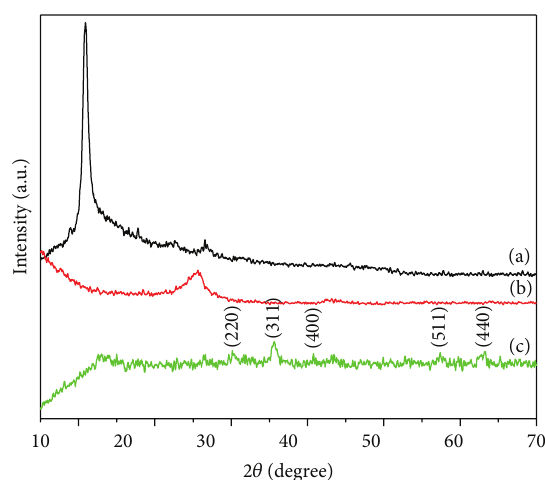
Figure 1: XRD patterns of GO (a), rGO (b), and Fe 3 O 4 /rGO (c).